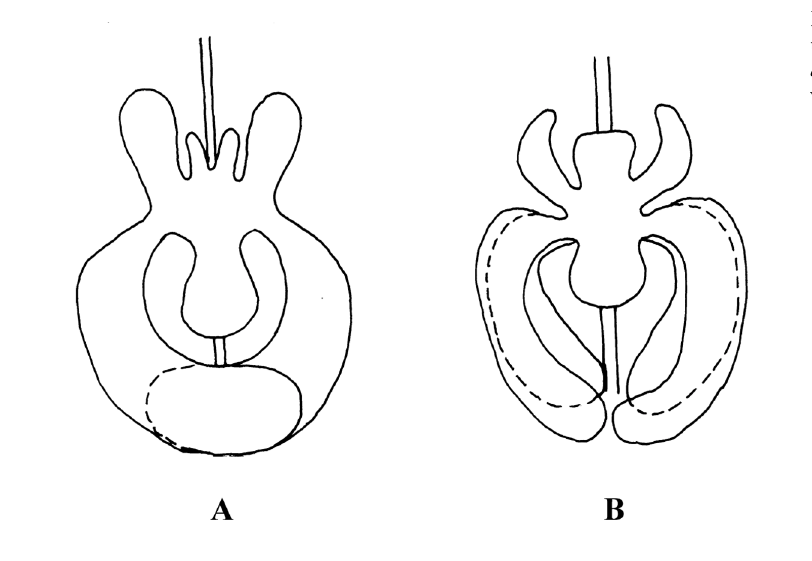
Fig. 7. Schematic drawings of diver- ticula in Ph. persimilis (A) and A. an- dersoni (B) (from Akimov and Staro- vir 1978,